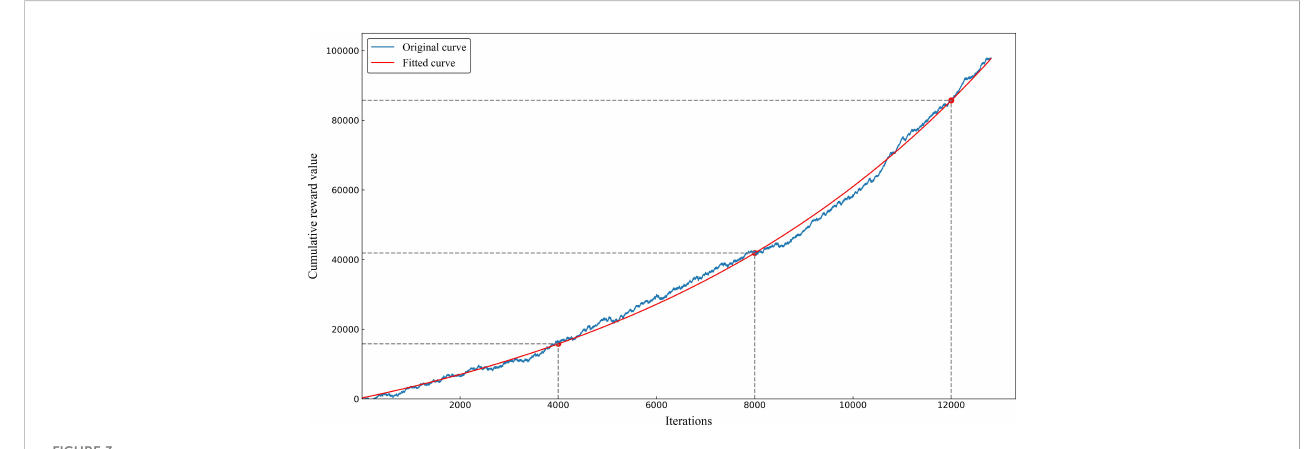
FIGURE 3 Correlation between the total training iterations and the cumulative reward